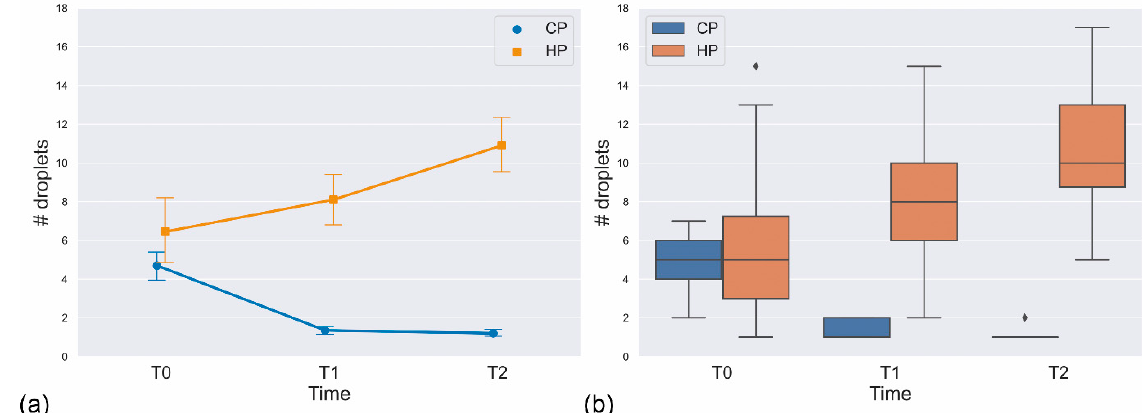
Figure 3. ( a ) Mean scores (number of droplets normalized to an area of 1000 μ m 2 ) at different treatment times for the group treated with carbamide peroxide (CP) and the group treated with hydrogen peroxide (HP). The vertical bars represent the standard deviations calculated at each point. ( b ) Box plot representation of the dispersion of the data.